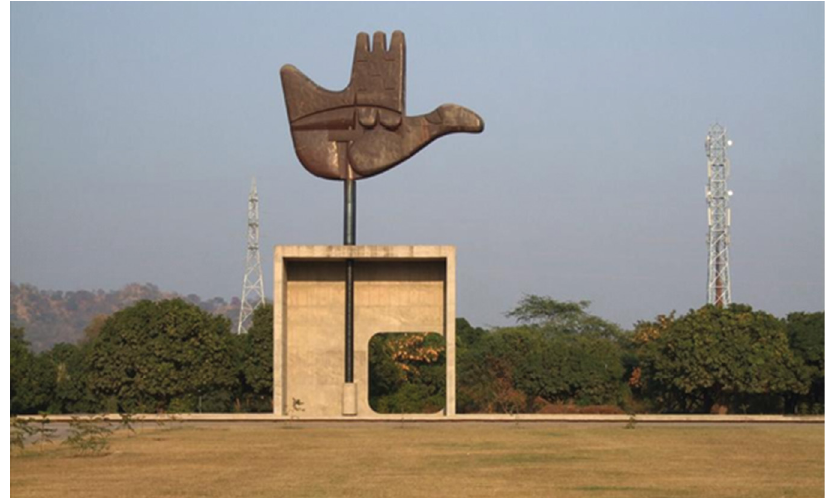
Figure 8. “Main Ouverte”, Chandigarh, India. ©Fondation Le Corbusier (FLC) / ADAGP. Available